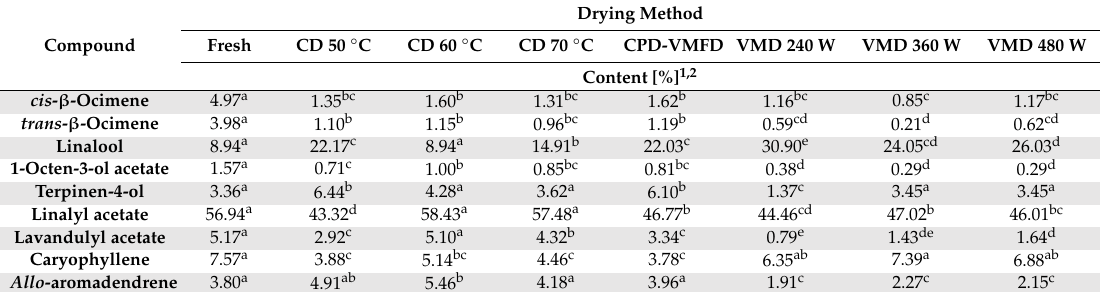
Table 4. Contribution of major volatile compounds in the volatile profile of true lavender flowers a ff ected by various drying